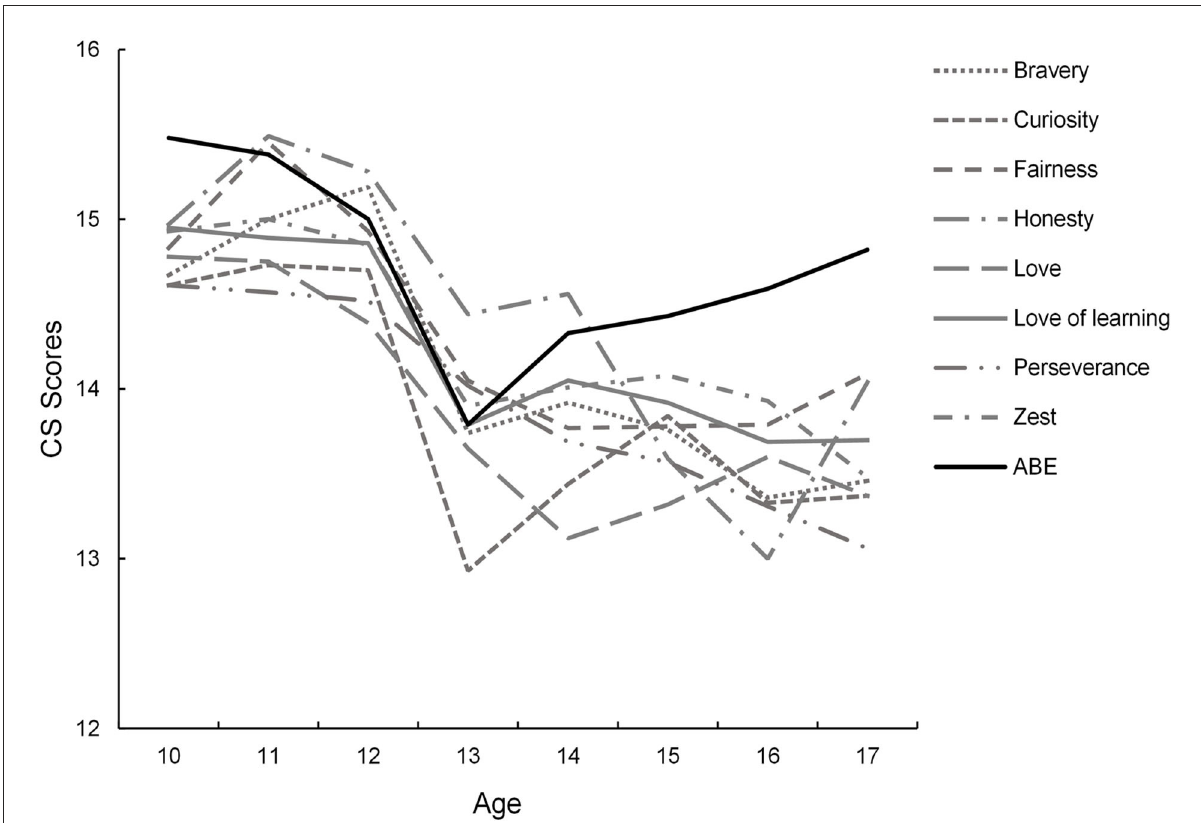
FIGURE2 The age-related changes in CSs. Only CSs showed significant age-related changes were presented, including appreciation of beauty and excellence (ABE), bravery, curiosity, fairness, honesty, love, love of learning, perseverance, and zest.